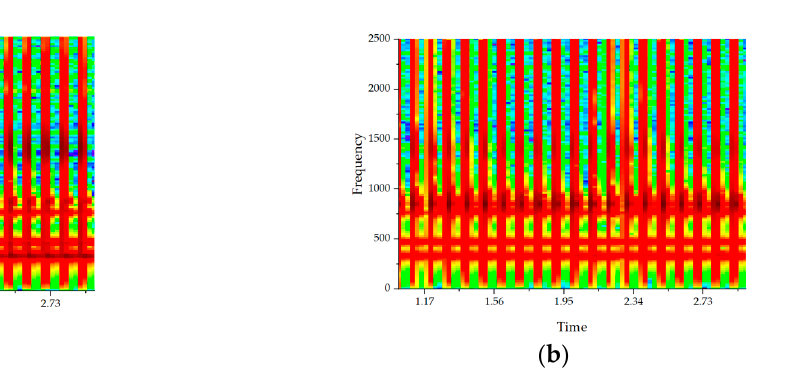
Figure 12. Constant-amplitude continuous impulse excitation acceleration response.